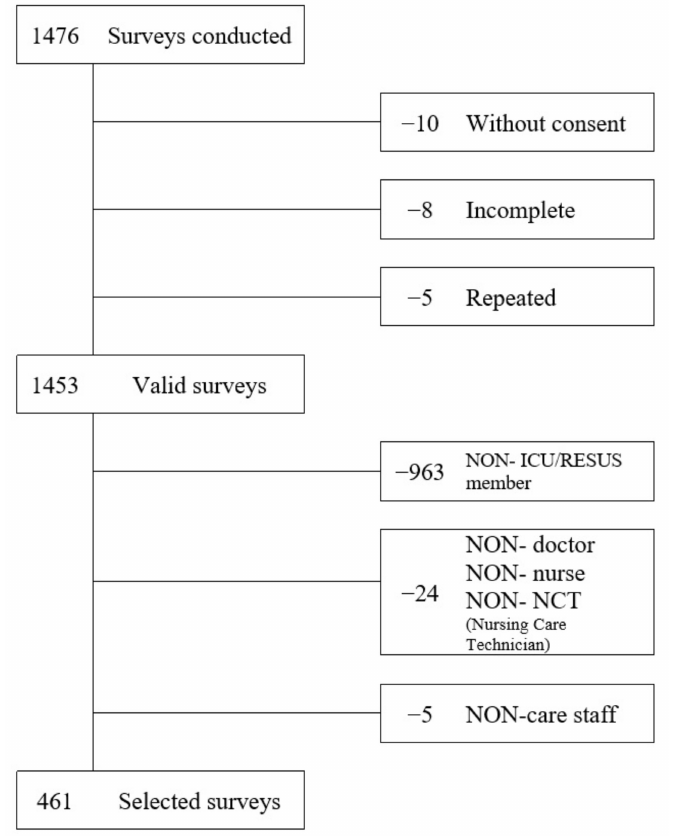
Figure 1. Study sample